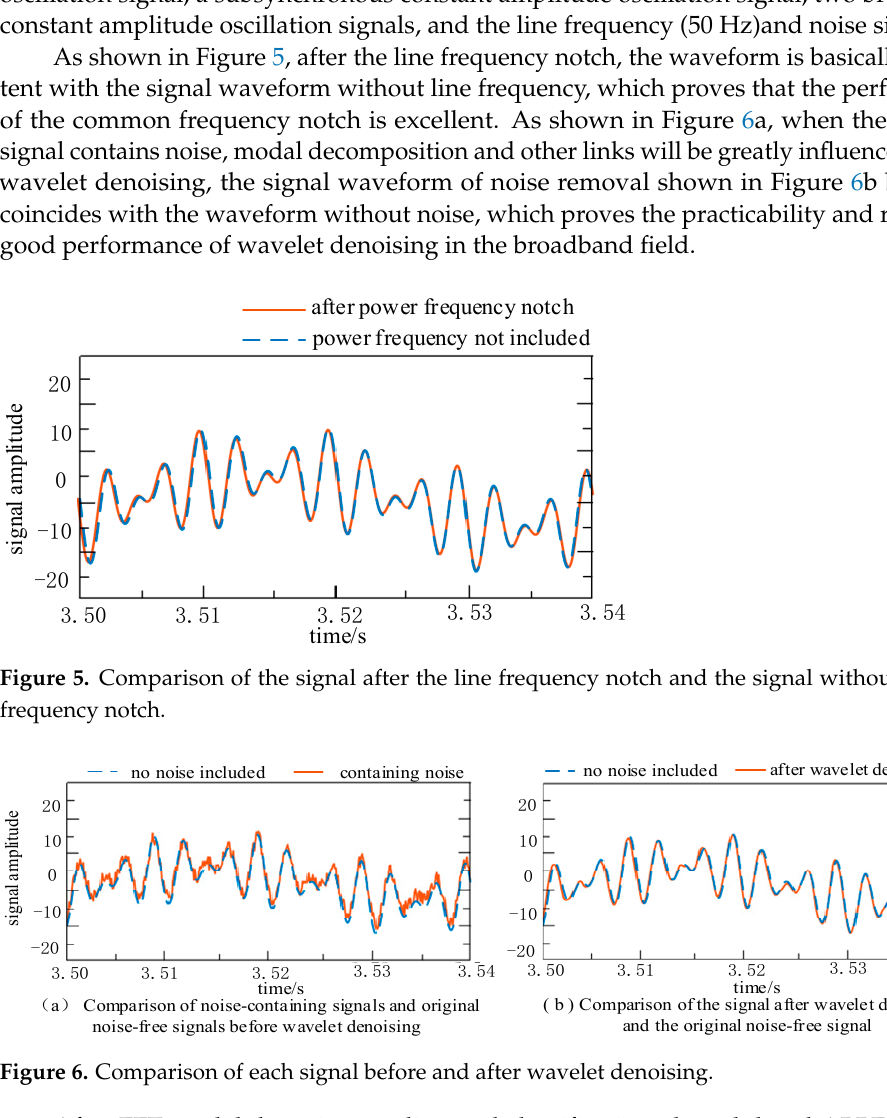
Figure 7. Comparison of phase compensation waveform before and after.